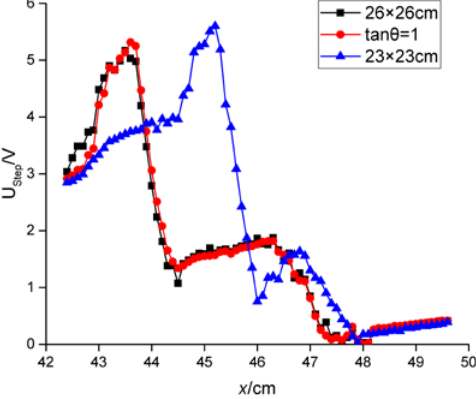
Figure 10. The changes in step voltage changes with agar size.